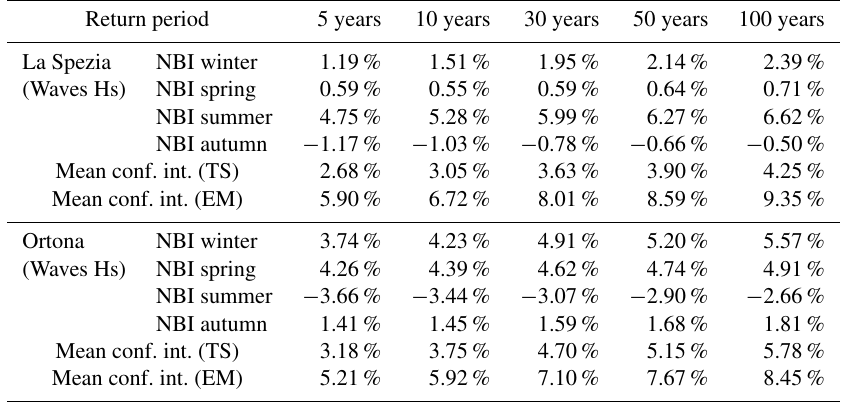
Table 4. Normalized bias between the return levels estimated by the TS methodology and the EM methodology for the estimation of the seasonal variations, and mean 95% confidence interval amplitude expressed as percentage of the return level, for return periods of 5, 10, 30, 50, and 100 years, for the four seasons, for significant wave height in La Spezia and